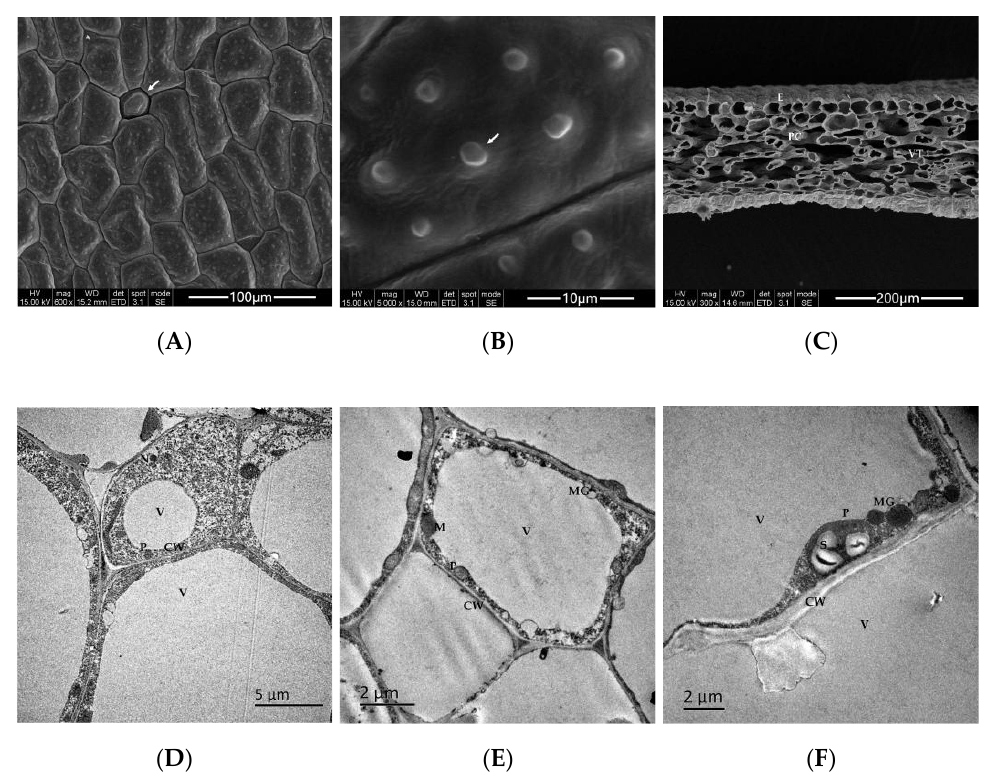
Figure 1. Basic structure of the flower petal of N. hybrid. ( A – C ) Scanning electron microscopy (SEM) images; ( A ) epidermis cells of the petal, bar = 100 µ m; ( B ) papillae on the epidermal cell, bar = 10 µ m; ( C ) longitudinal profile of the petal, bar = 200 µ m. ( D – F ) Transmission electron microscopy (TEM) images; ( D ) cell wall, nucleus, vacuole, and so on, bar = 5 µ m; ( E ) mitochondria, osmiophilic matrix granule, plastid, bar = 2 µ m; ( F ) starch grains and osmiophilic matrix granules in the cytoplasm, bar = 2 µ m. E: epidermis; PC: parenchymal cell; VT: vascular tissue; CW: cell wall; N: cell nucleus; V: vacuole; P: plastid; M: mitochondria; S: starch grain; MG: osmiophilic matrix granule. These same abbreviations are used below.